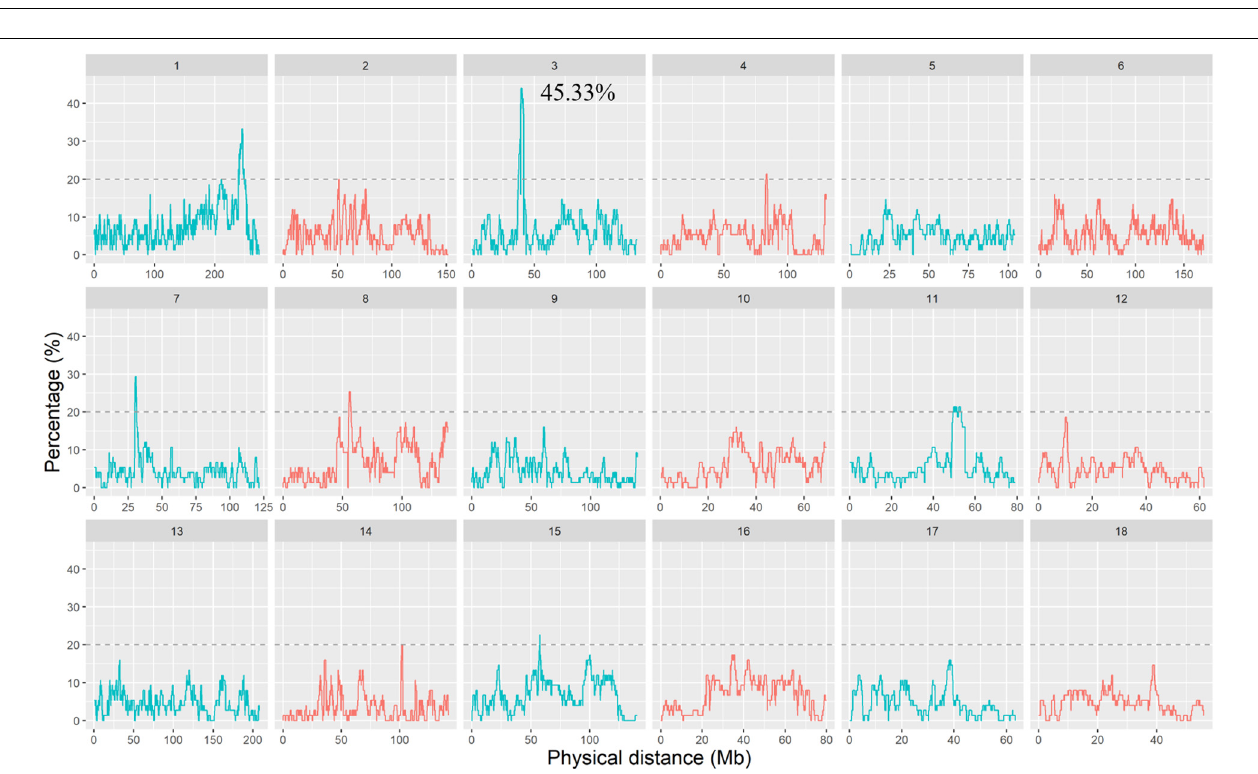
FIGURE 2 | Relationship between the number of ROHs and the length of each ROH. The x -axis denotes the physical distance of ROHs (Mb), and the y -axis represents the number of ROHs.